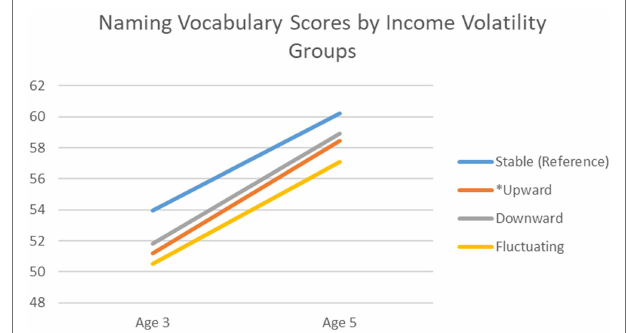
FIGURE 2 | Trajectory of naming vocabulary scores from age 3 to 5 across income volatility groups. Note: *Statistically significant change between volatility group and stable income group in the regression analysis.